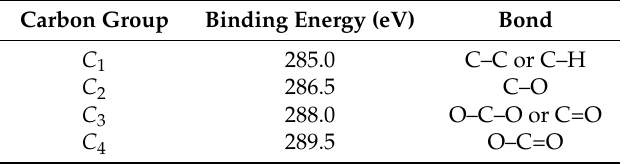
Table 2. Deconvoluted peak assignments with corresponding theoretical binding energy and bond type for high-resolution XPS scans of C 1s.